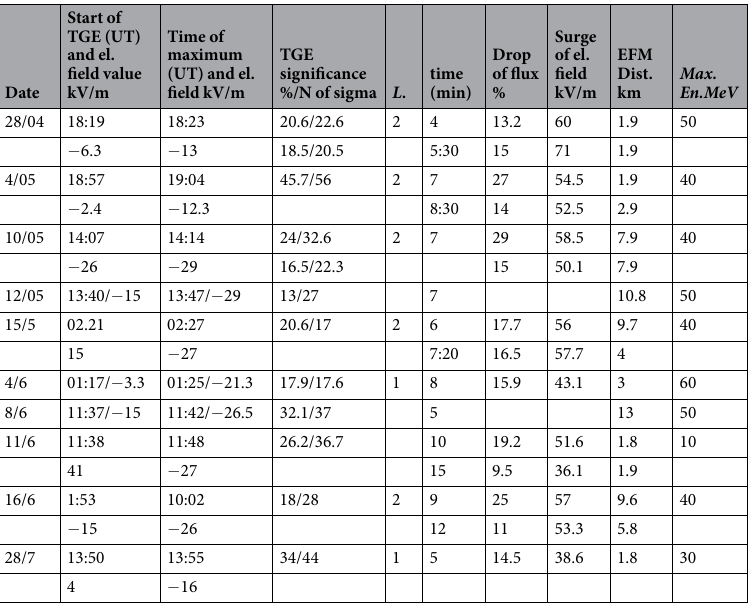
show in the Table the time of maximum and corresponding electrostatic field only for the first (usually largest) peak. One-minute time series of the particle detectors with low energy threshold demonstrate huge enhancements equivalent to tens of standard deviations. The differential energy spectrum of gamma rays extends up to 40 MeV and beyond proving intense RREA process in the thundercloud above the detector site. The strong negative light- ning is seen as an abrupt increase of the near-surface electrostatic field with an amplitude of ~50 kV/m and more; all observed lightning discharges that terminated TGE events at Aragats lowered the negative charge overhead. Only nearby lightning flashes (within 10 km) terminated TGE. Only in 2 events from 10, we do not register an abrupt decline of TGE flux and nearest lightning flashes for these events were at distance more than 10 km. In 8 events from 10 nearby lightning abruptly terminated TGE.